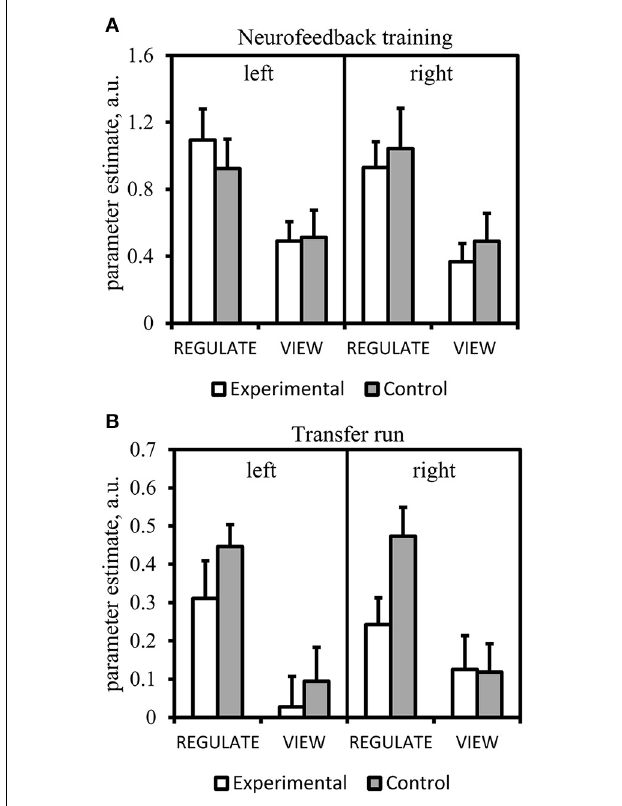
FIGURE 6 | Results of the region-of-interest analysis of the anterior insula. Mean parameter estimate of all voxels within the anterior insula masks of the REGULATE > NEUTRAL and VIEW > NEUTRAL contrast. Error bars indicate standard error of mean. A.u., artificial units. (A) Neurofeedback training (mean over all runs). (B) Transfer